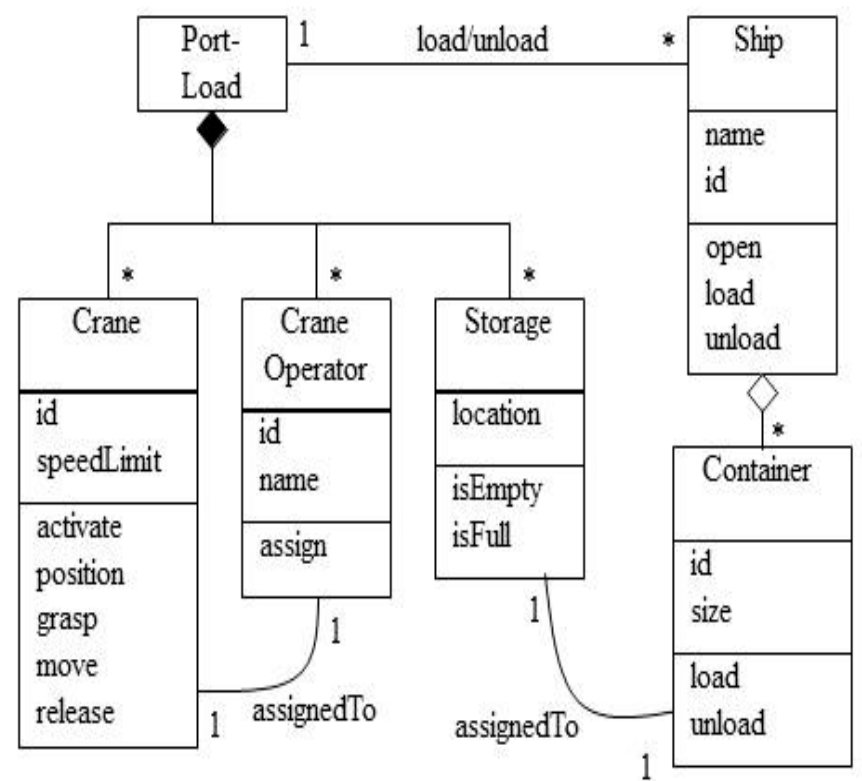
Figure 8. Class diagram of port loading system.